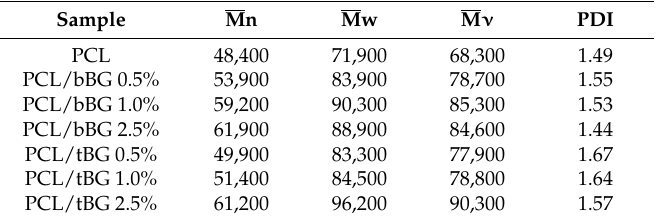
Table 1. Molecular weight and PDI values measured by